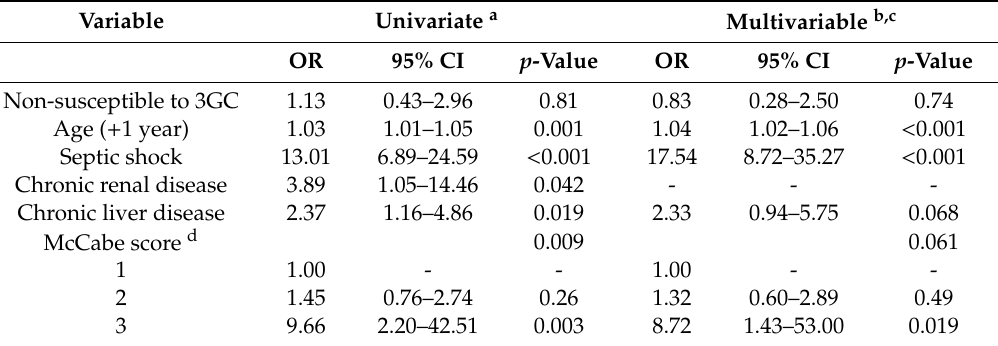
Table 2. Univariate and multivariate logistic regression analyses of predictors of 30-day